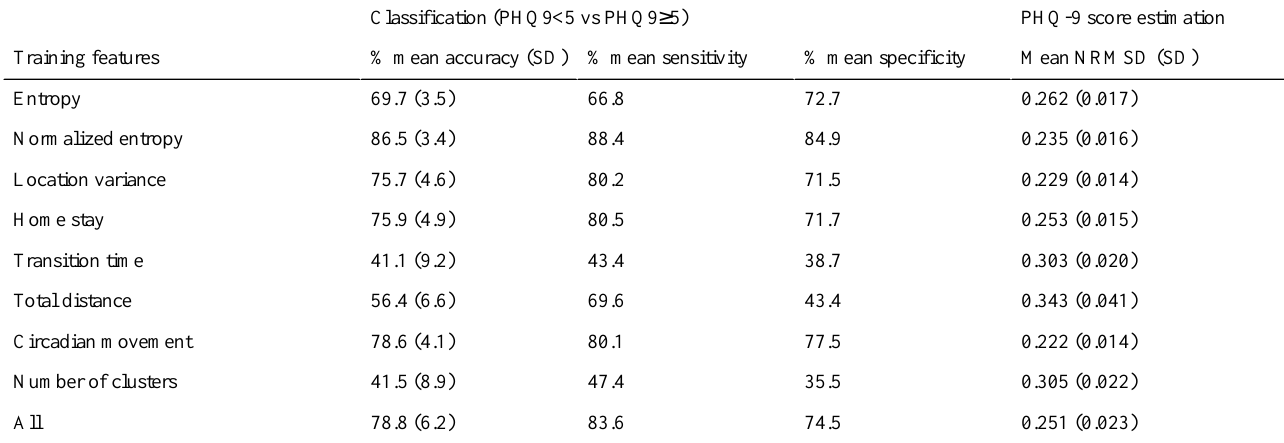
Table 1. Classification of participants with and without depressive symptoms and estimating their PHQ-9 scores using location features individually and aggregated.